Question: Based on the figure, does the quantity rise or fall?
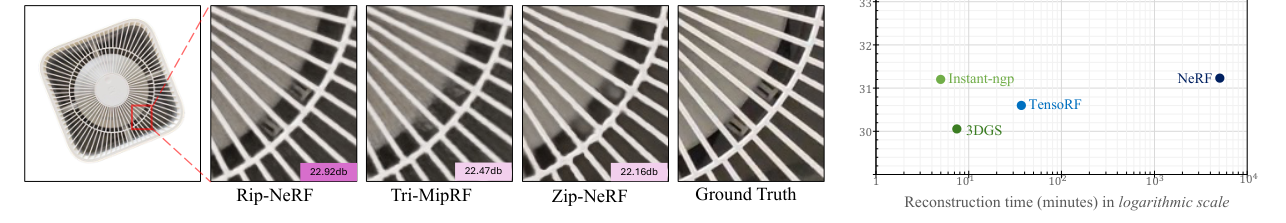
Answer: decreasing